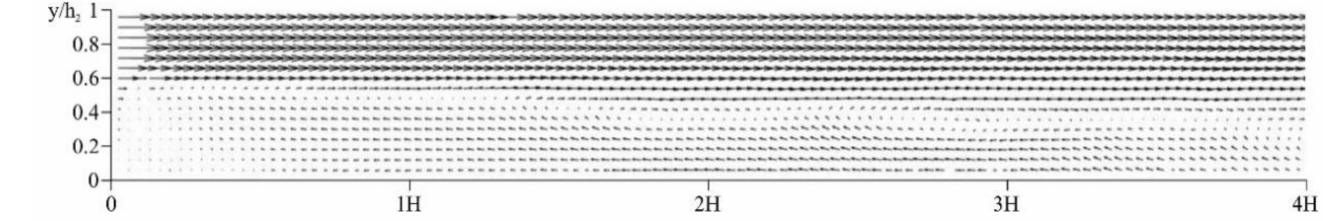
Figure 7. Velocity distribution on the channel centerline.